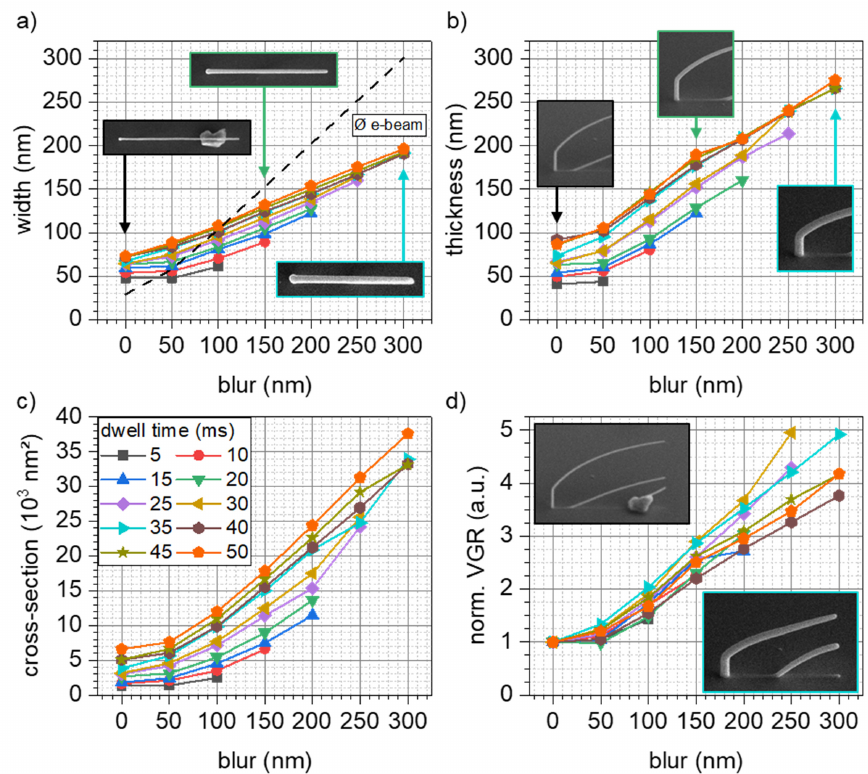
Figure 2. Implication of beam blurs on ( a ) segment widths, ( b ) thicknesses-, ( c ) cross-sectional areas and ( d ) relative efficiencies. All data are grouped by different DTs (see legend in c). While the dashed line in ( a ) indicates the calculated beam diameter by the instrument, the insets in ( a , b ) give directly comparable top and tilted SEM images, respectively. Volume growth rates were always normalized to in-focus conditions (blur = 0) to show the efficiency boost aside of absolute volume growth rates.